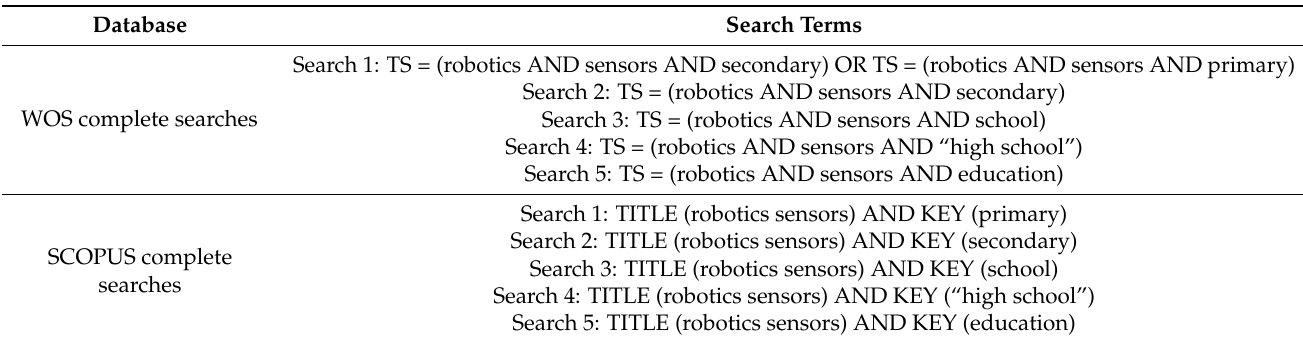
Table 1. Search terms and fields for Research Question 1.